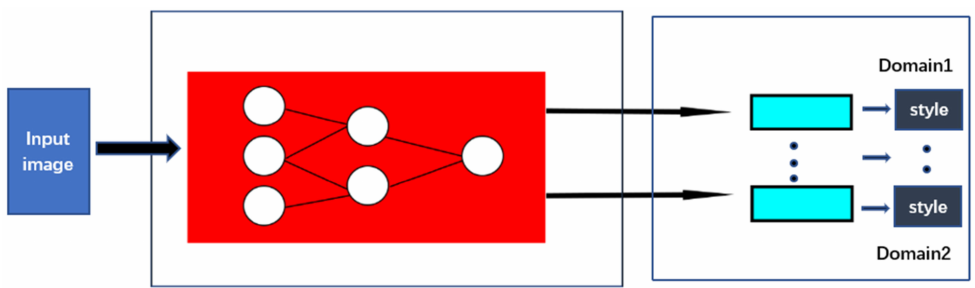
Figure 2. Style encoder.